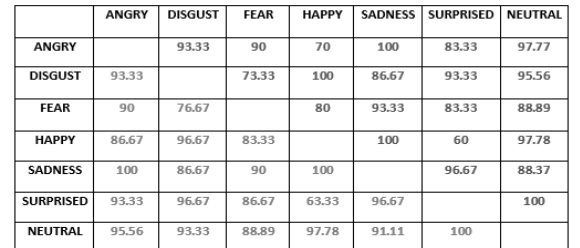
Table 4. Accuracies between pairs of emotions in SAVEE dataset with spectral contrast